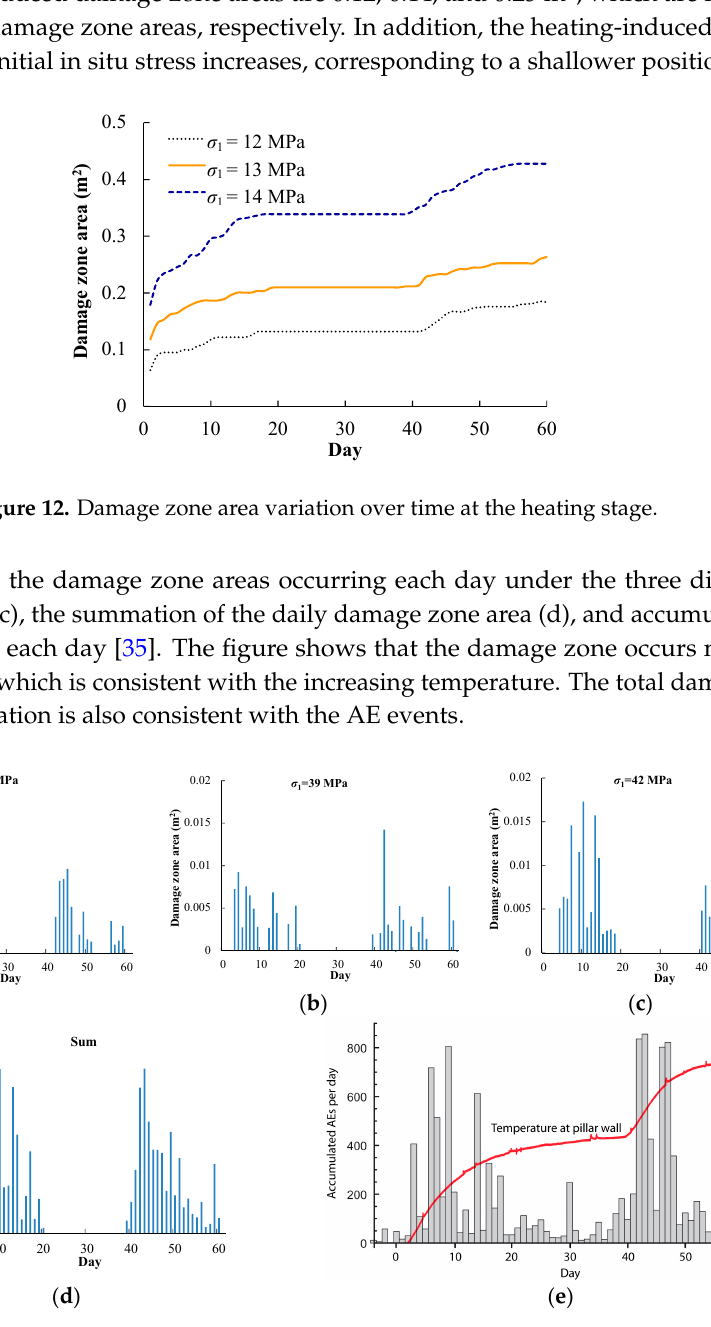
Figure 13. Comparison of damage zone area: ( a ) σ 1 = 36 MPa; ( b ) σ 1 = 39 MPa; ( c ) σ 1 = 42 MPa; ( d ) total damage zone area in simulation; ( e ) accumulated AE events each day [35], courtesy of SKB (from SKB TR-07-01 (Andersson 2007)).